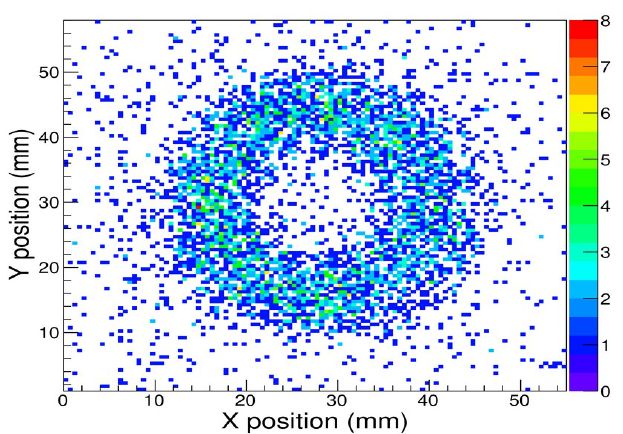
Fig. 11: GEANT4 simulated image of the scatterer (ring) in position sensitive detector with energy gated condition: 490 keV < E LaBr3(Ce)-PSPMT < 530 keV and 150 keV < E BGO < 250